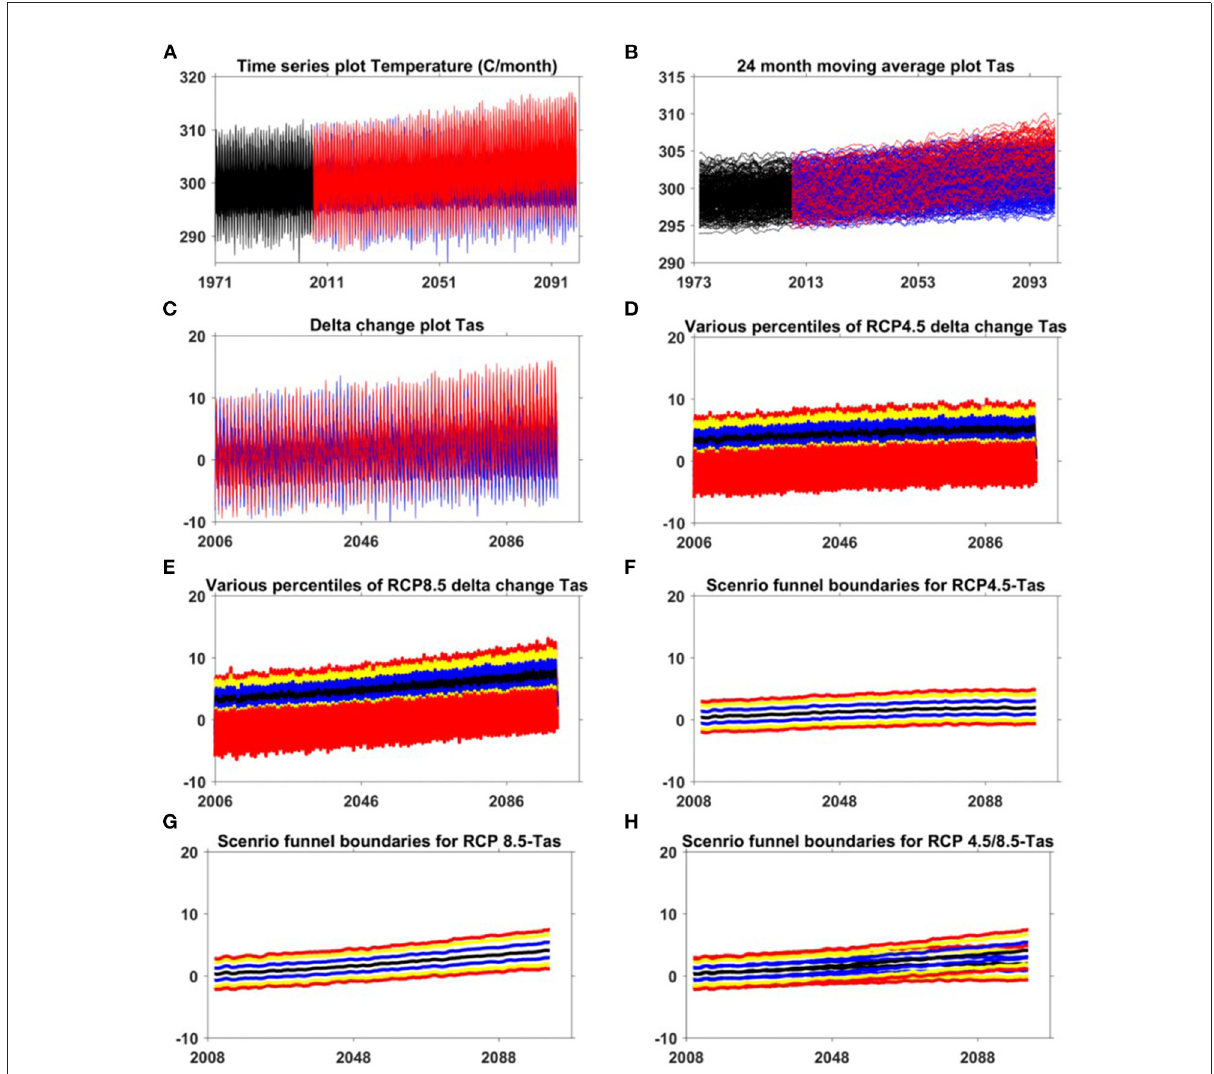
FIGURE4 The plot of various steps in developing the scenario funnel for average surface temperature [T as, (A–H) ] by data-analysis, (A) time-series plot of raw temperature data, (B) time-series plot of 24 month moving average temperature data, (C) time-series plot of delta change estimated for temperature, (D) various percentile values for RCP 4.5 for temperature (red: 5th, 95th; yellow:10th, 90th, blue: 25th, 75th, black: 50th percentiles), (E) various percentile values for RCP 8.5 for temperature (red: 5th, 95th; yellow:10th, 90th, blue: 25th, 75th, black: 50th percentiles), (F) Developing scenario funnel boundaries for RCP 4.5 from 24 month moving average of the percentiles (red: 5th, 95th; yellow:10th, 90th, blue: 25th, 75th, black: 50th percentiles), (G) Developing scenario funnel boundaries for RCP 8.5 from 24 month moving average of the percentiles (red: 5th, 95th; yellow:10th, 90th, blue: 25th, 75th, black: 50th percentiles), (H) scenario funnels for temperature. In (A–C) , red and blue color represents the RCP 8.5 and RCP 4.5, respectively. (For interpretation of the references to color in this figure legend, the reader is referred to the web version of this